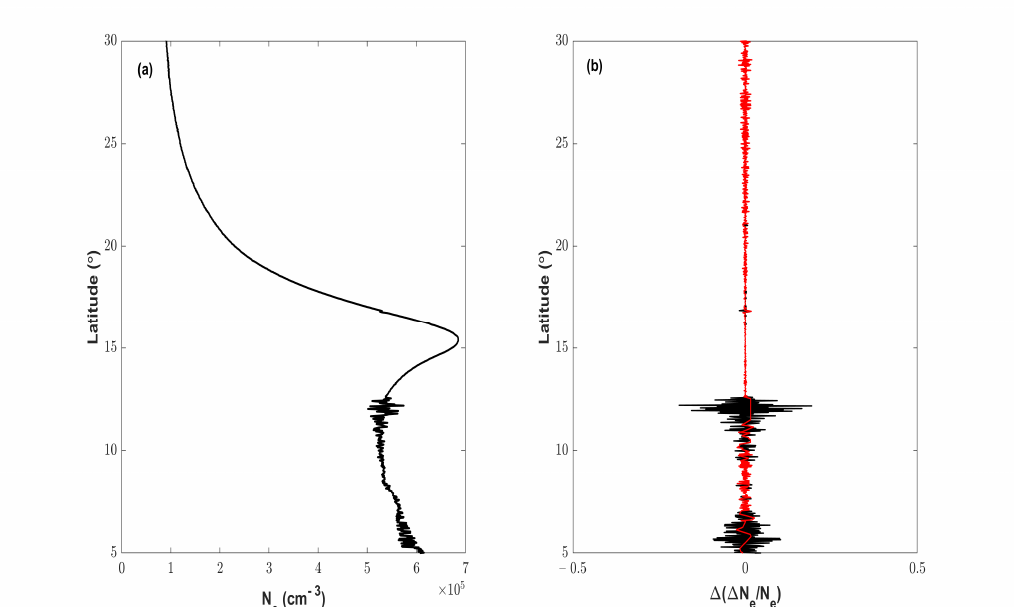
Figure 19. NeSTAD analysis on a track recorded for Swarm (SAT-C) on 29 October 2020. ( a ) The left panel shows the electron density variation on the sat-C track number 15 as a function of latitude, ( b ) the right panel shows the anomaly in the 5 ◦ N to 30 ◦ N latitude range.